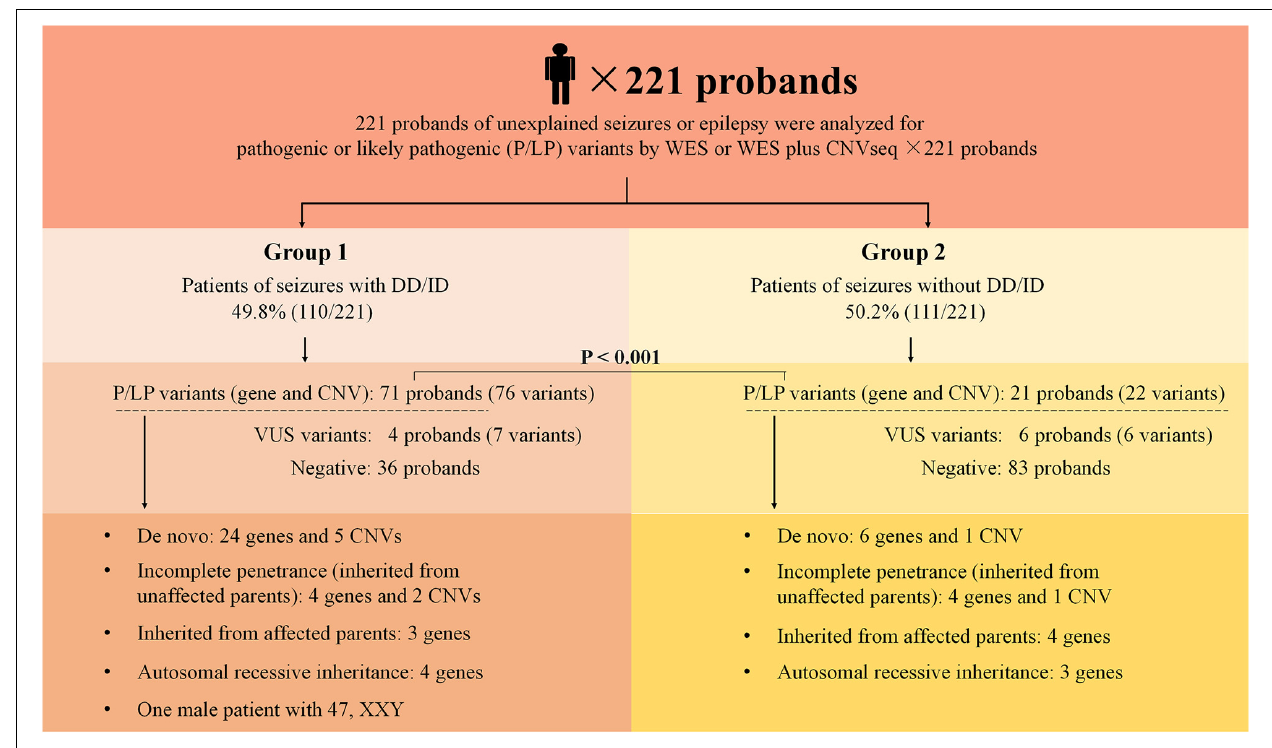
FIGURE 1 | Schematic summarizing the 221 probands from non-consanguineous pedigree. Two groups were considered in this study: epilepsy with DD/ID and epilepsy without DD/ID. Pathogenic or likely pathogenic variants were categorized as: De novo , incomplete penetrance, inherited from affected parents, autosomal recessive inheritance. DD, developmental delay; ID, intellectual disability; P, pathogenic; LP, likely pathogenic; VUS, variant uncertain significance; CNV, copy number variant; CNVseq, CNV sequencing; WES, whole-exome